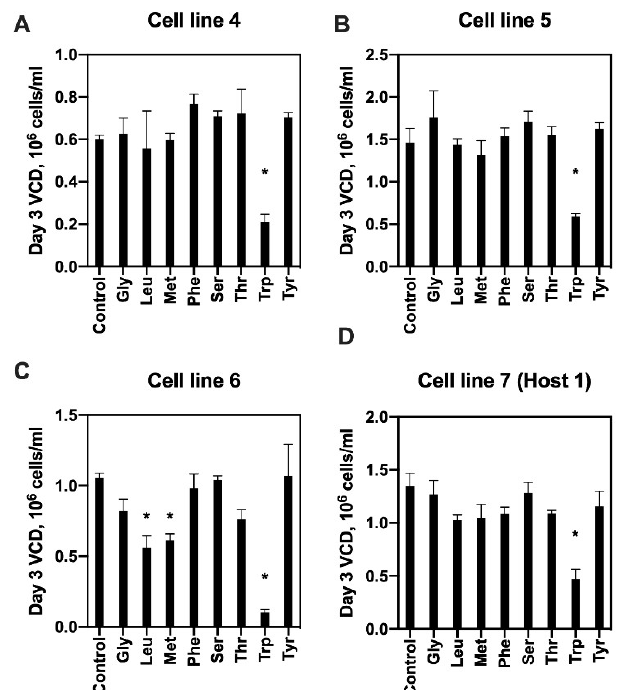
Figure 4. E ff ects of amino acid supplementation on cell growth. Host 2-derived cell lines 4–6 ( A – C ) and host 1-derived cell line 7 ( D ) were cultured in basal medium (control) or basal medium supplemented with one of eight amino acids at 10 × their basal medium concentration. Each culture was carried out in duplicate. Bar graph values show viable cell density (VCD) measured on day 3. *: Benjamini–Hochberg procedure-adjusted ANOVA p -value <